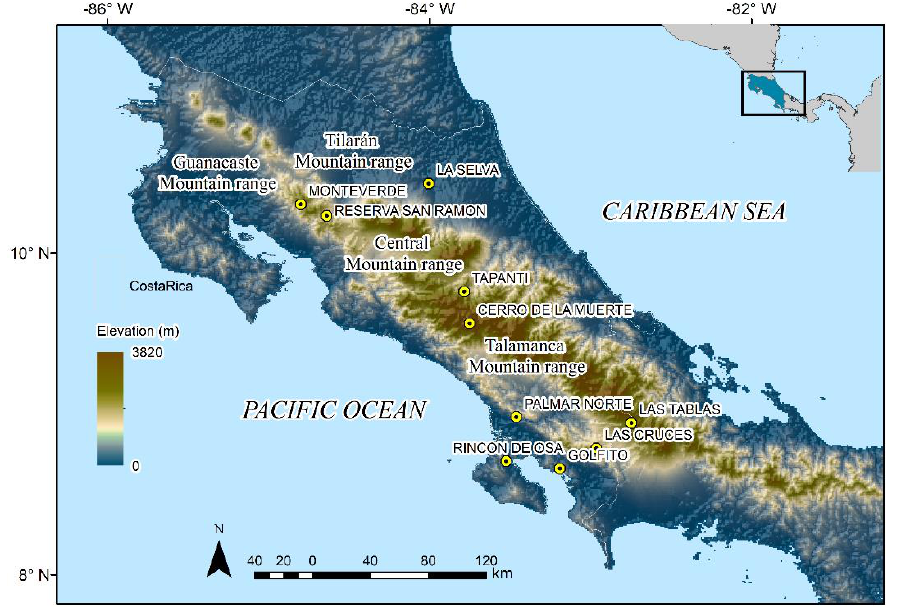
Figure 1. Map of Costa Rica showing ten historical localities (all caps) and main mountain ranges where long-term monitoring has been conducted even before amphibian declines occurred during the 1980s and 1990s.